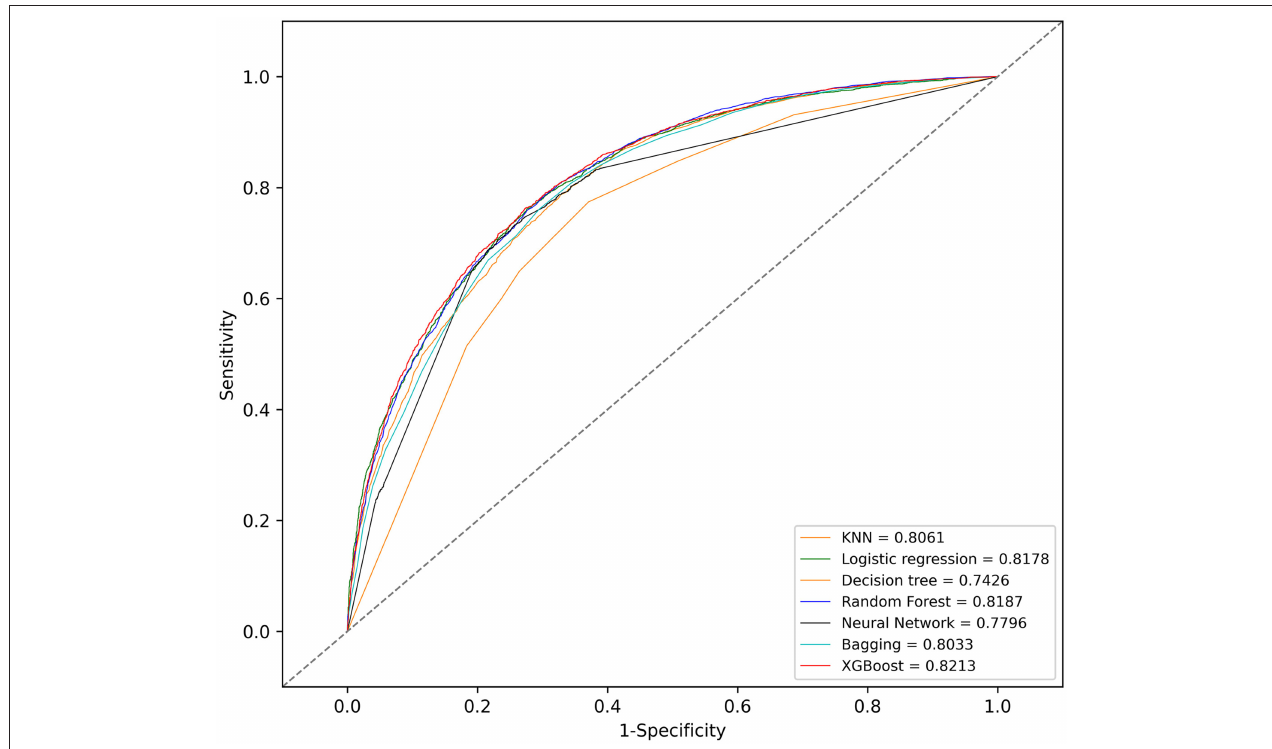
FIGURE 2 | Receiver operating characteristic (ROC) curves of the seven models. KNN, k-nearest neighbors; XGBoost, Extreme Gradient Boosting.